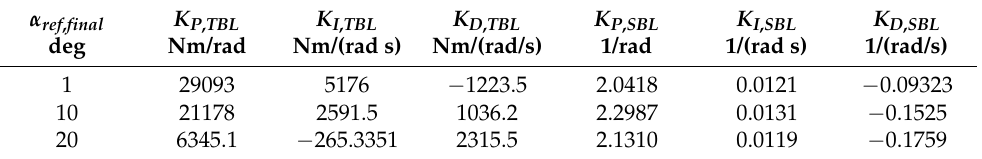
Table 3. Optimal Proportional Integral Derivative (PID) set of gains for different final hitch angles at u 1 = 20 km/h.